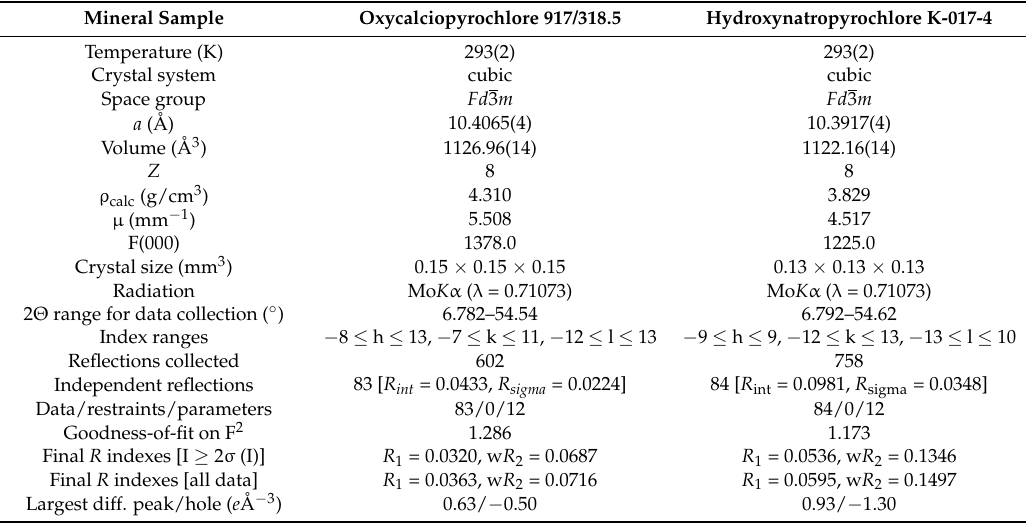
Table 6. Crystaldataandstructurerefinementforoxycalciopyrochlore917/318.5andhydroxynatropyrochloreK-017-4.